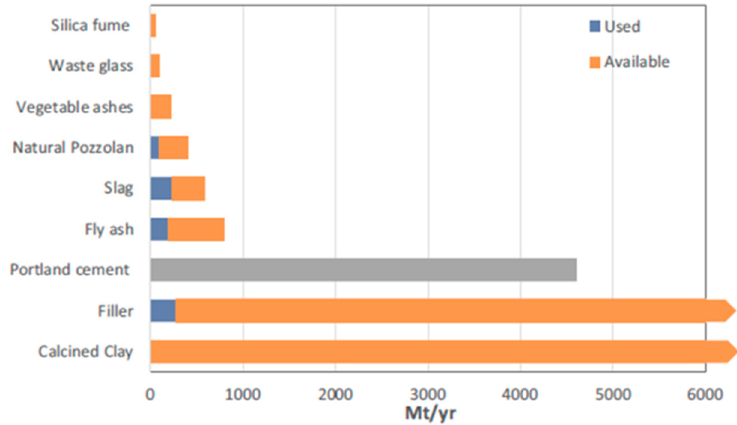
Figure 1. Estimated availability of possible SCMs vs. cement production [8].